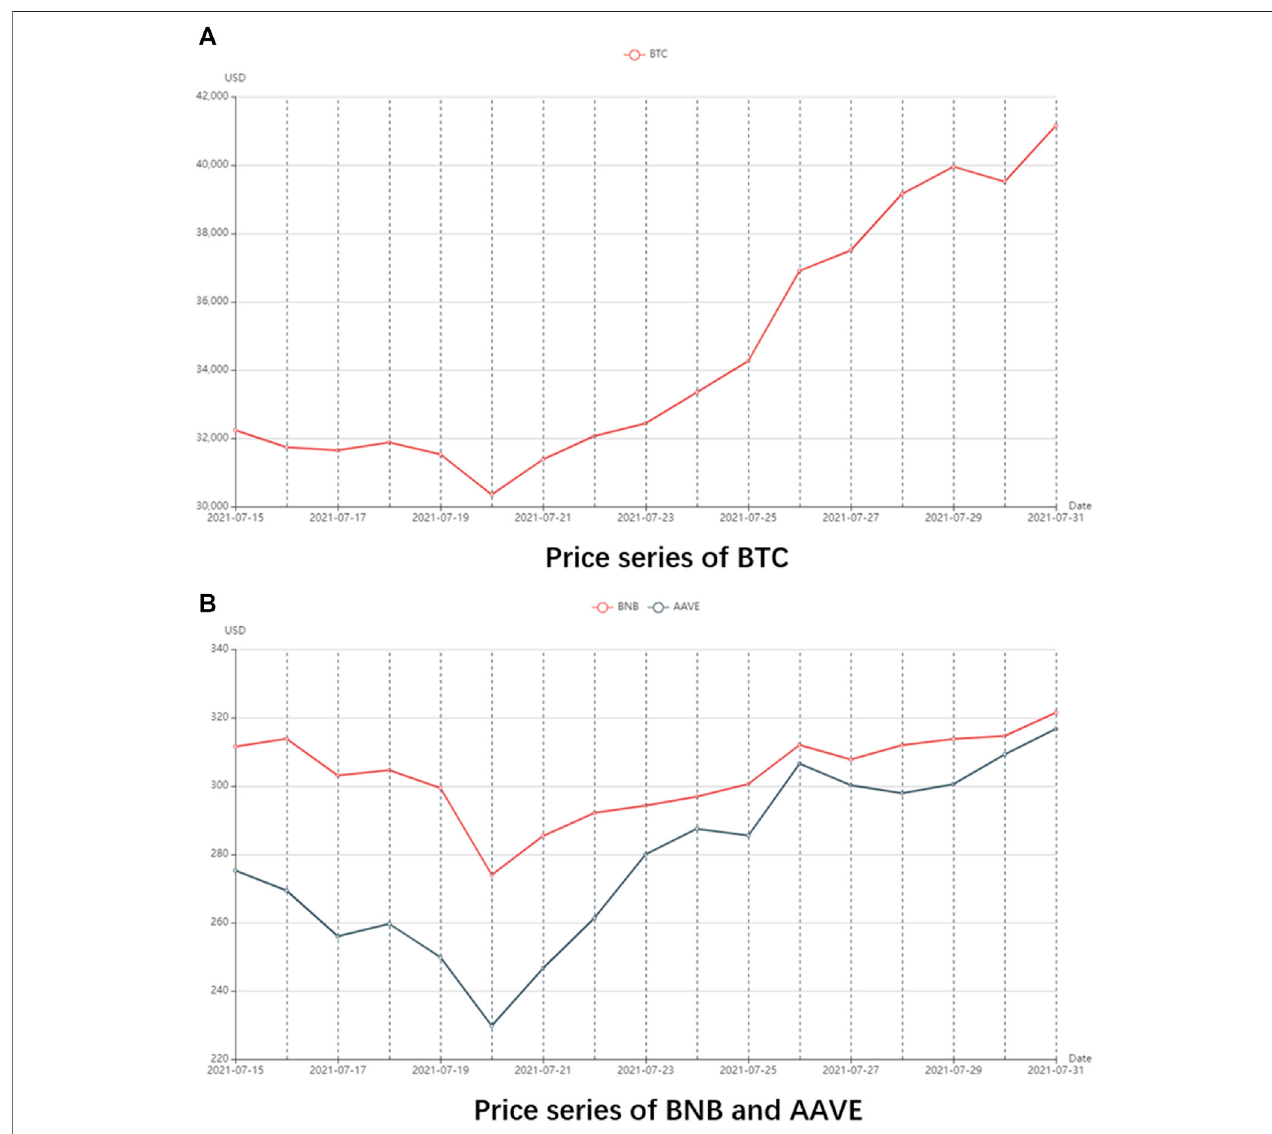
FIGURE 4 | Price series from July 15 to July 31. (A) Price series of BTC. (B) Price series of BNV and AAVE.